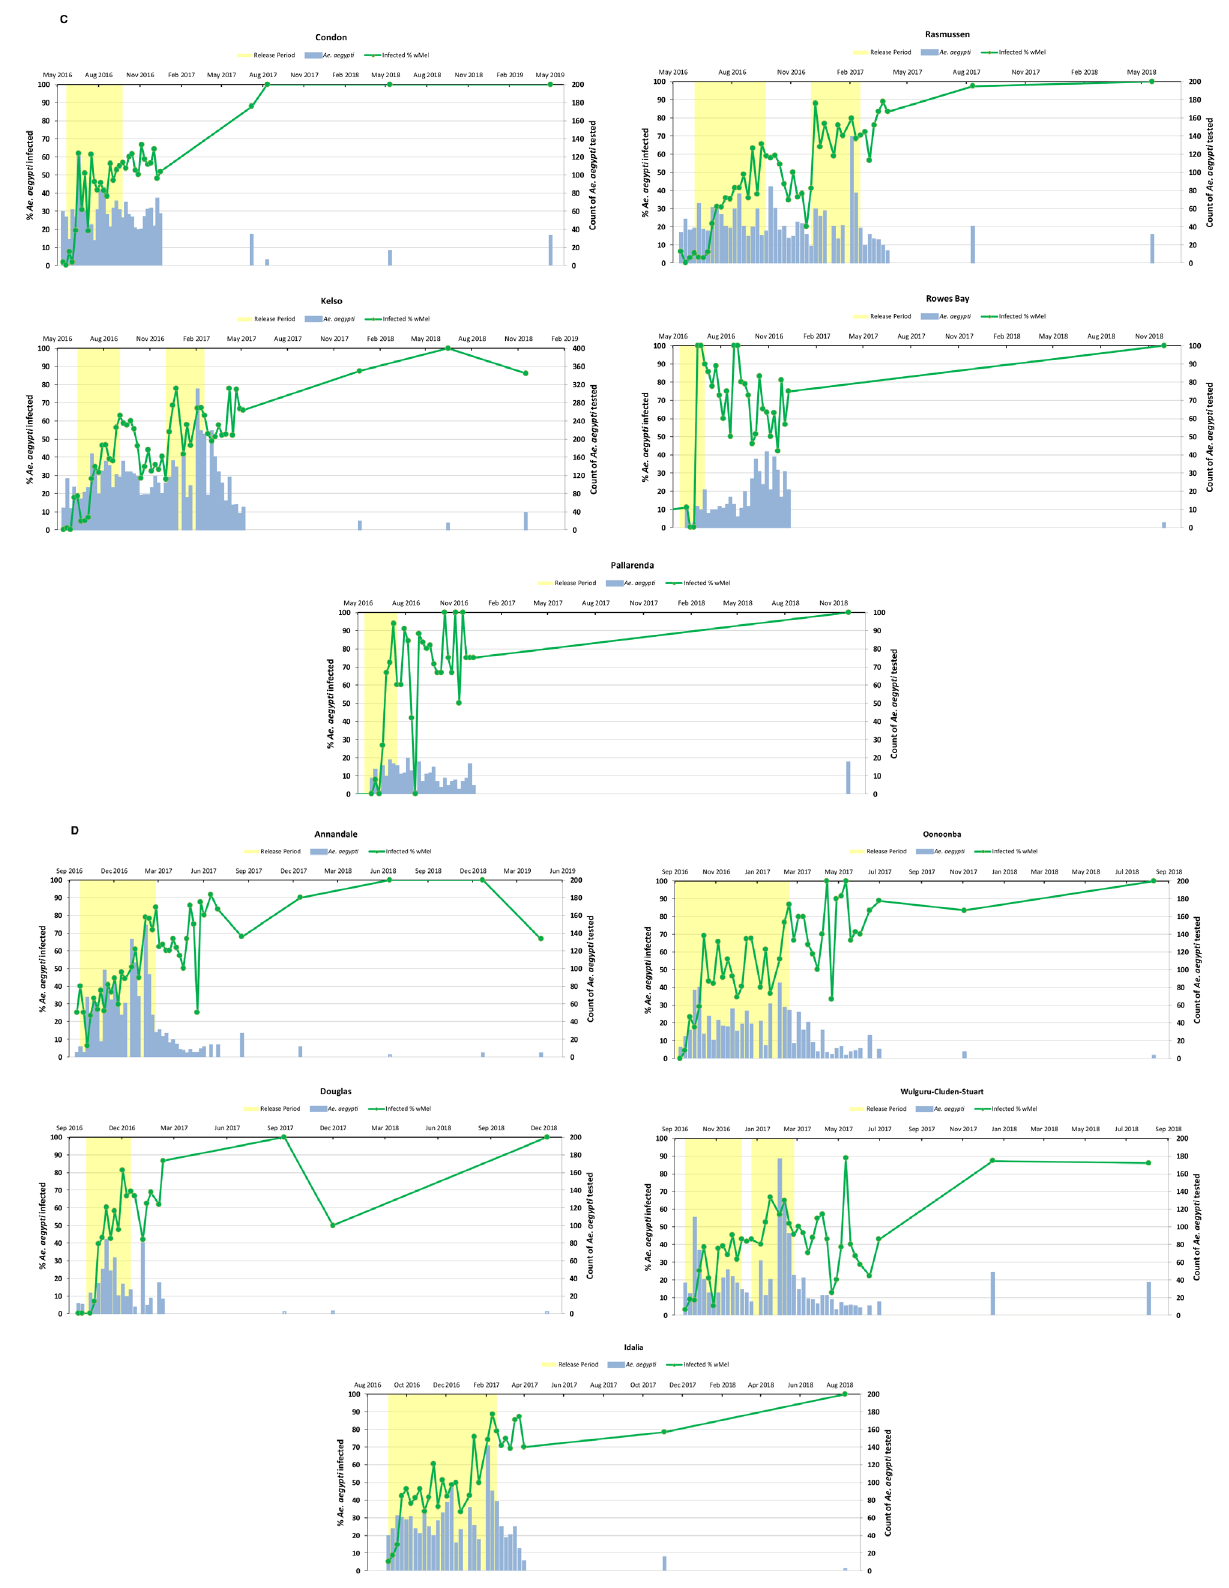
Figure 3. Wolbachia establishment by suburb. For each stage ( A – D ) and suburb Wolbachia frequency is plotted against time. Yellow shading indicates periods when releases were undertaken. Bars show the number of mosquitos captured in Biogents Sentinel (BGS) traps and tested for Wolbachia